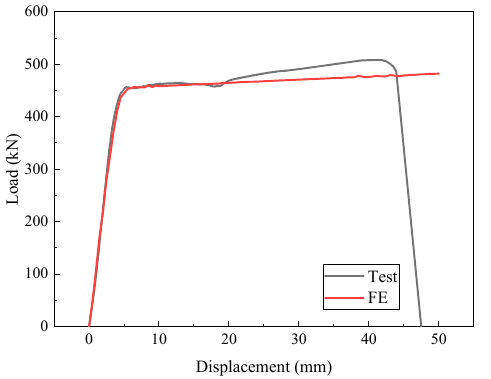
Figure 17. Load-displacement curves of the bolt-sphere joint with members from the test and FE.